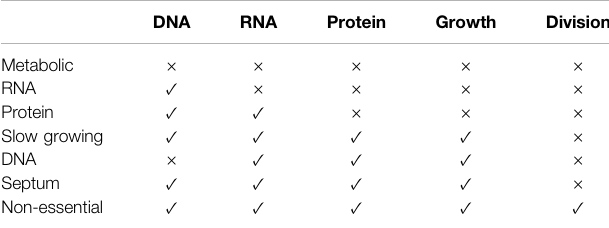
TABLE 2 | Manual labels of phenotypic classes (shown on the left-hand column) and their corresponding combinations of substance production (the column